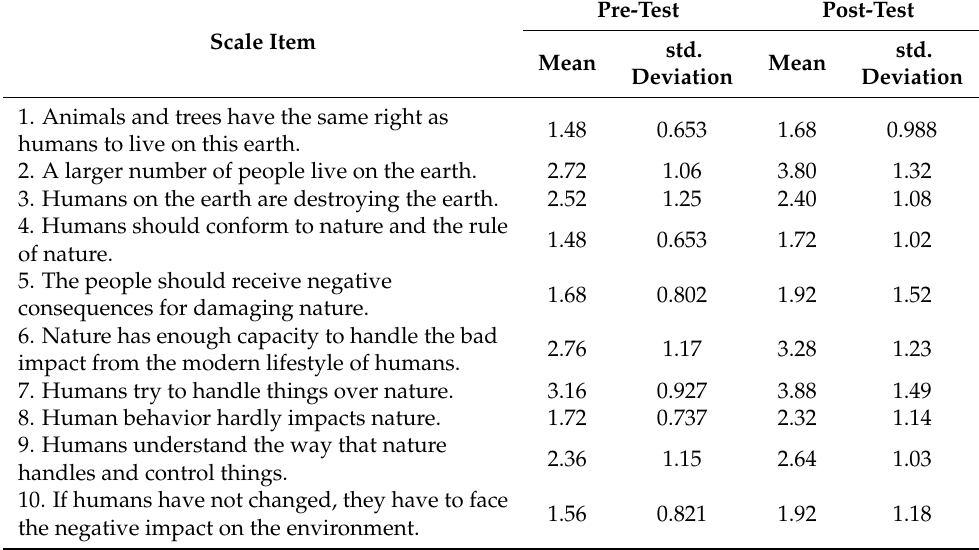
Table 1. Means and standard deviation result for the NEP (n =